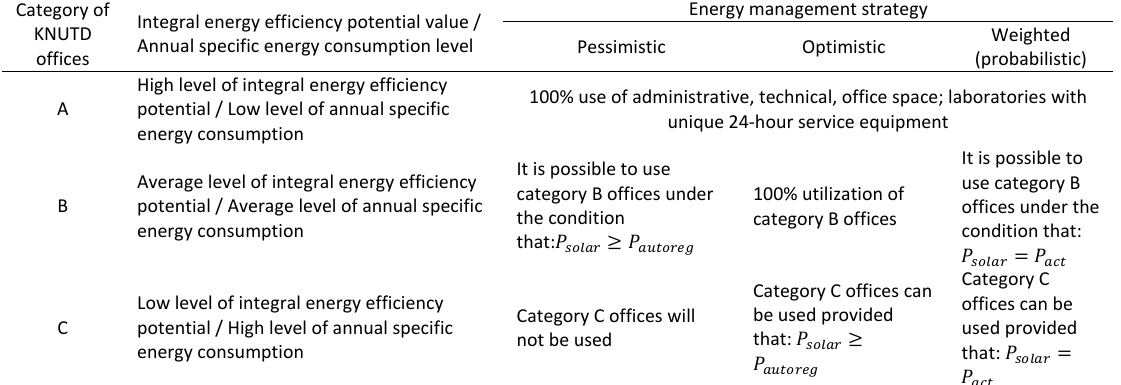
Table 7: Energy management action plan to improve the energy efficiency of the university